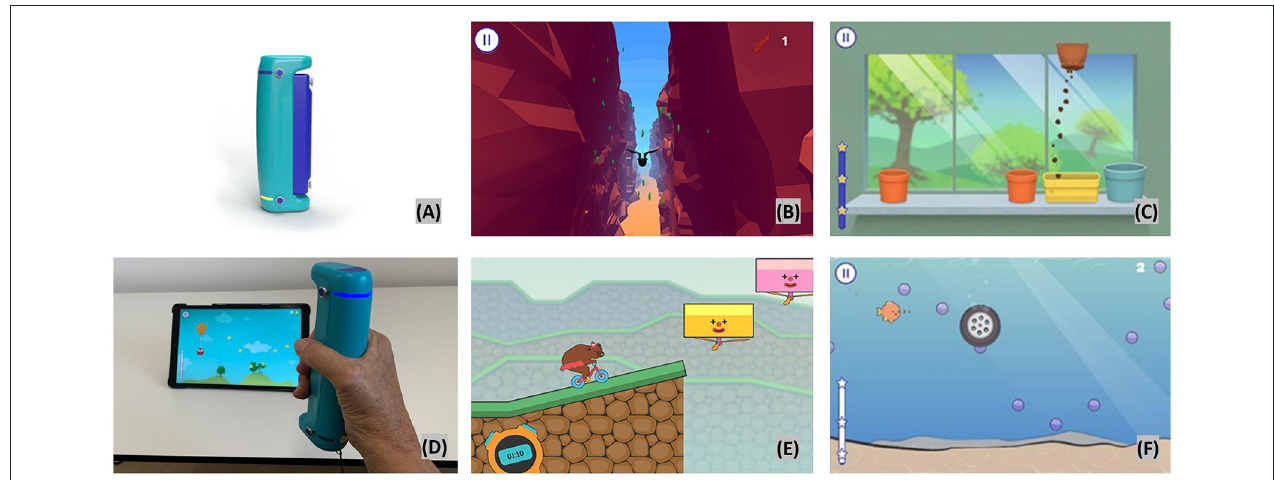
down the screen. The levels give increased time and complexity of the required control. The emphasis is on smooth transition between grip and release. The placement and the smoothness of the curve of stars alters through the levels to give gradual increase in demand (see Figure 2D bottom left).